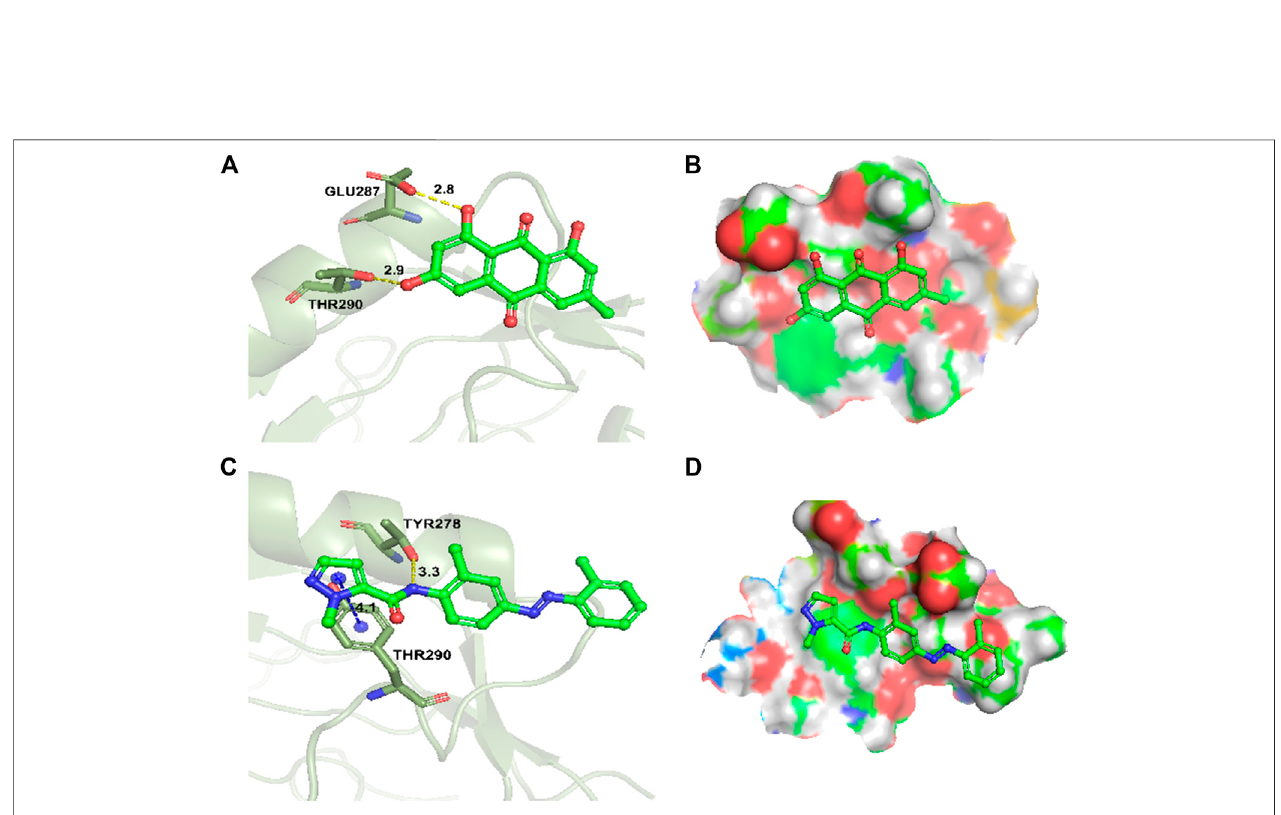
FIGURE 6 | Docking and binding pattern into AhR active site for compounds emodin (A,B) , AhR inhibitor CH223191 (C,D) . Hydrogen bonds – yellow lines, Pi- cation – blue lines.